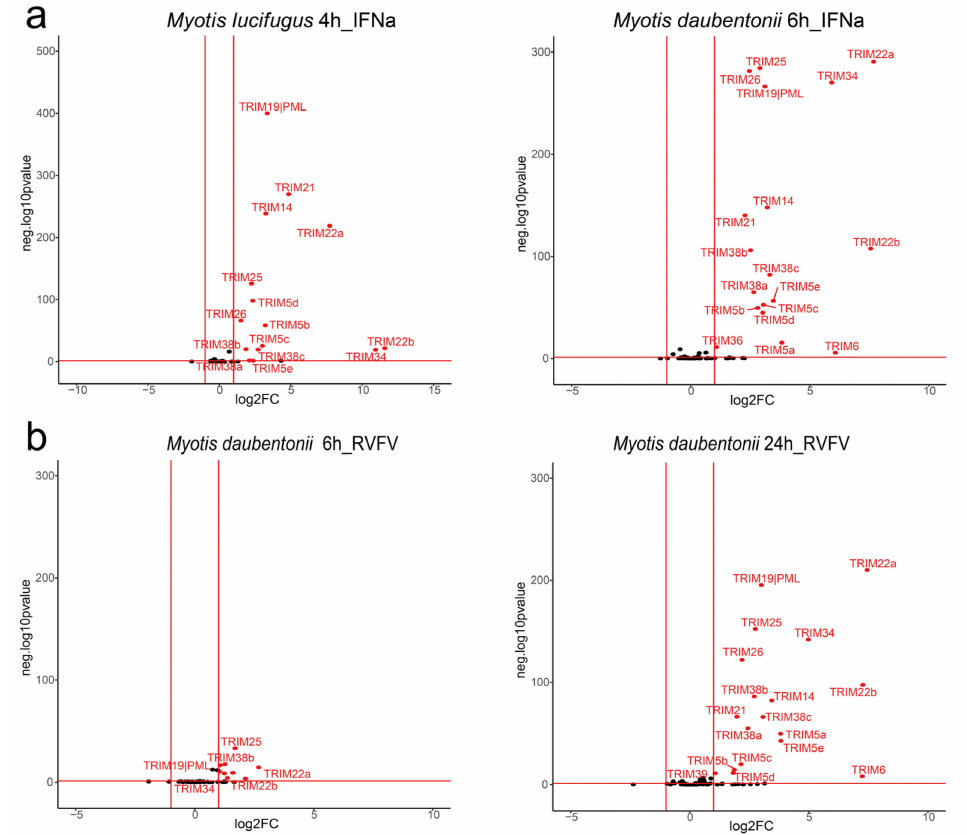
Figure 4. Differential TRIM gene expression of bat cells stimulated with IFN alpha ( a ) or infected with RVFV ( b ). On the X -axis is the log2 fold-change, and on the y -axis is the − log10 p -value. For more clarity, only TRIM genes are displayed, and those upregulated by at least two-fold with p -value less than 0.05 are highlighted in